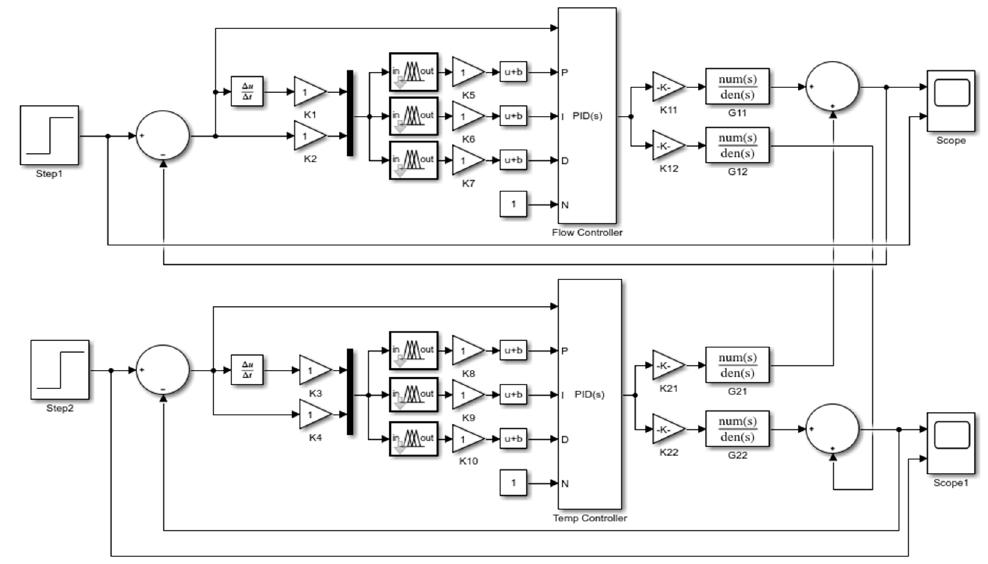
Figure 15. Simulink simulation of flow and temperature system (fuzzy PID).